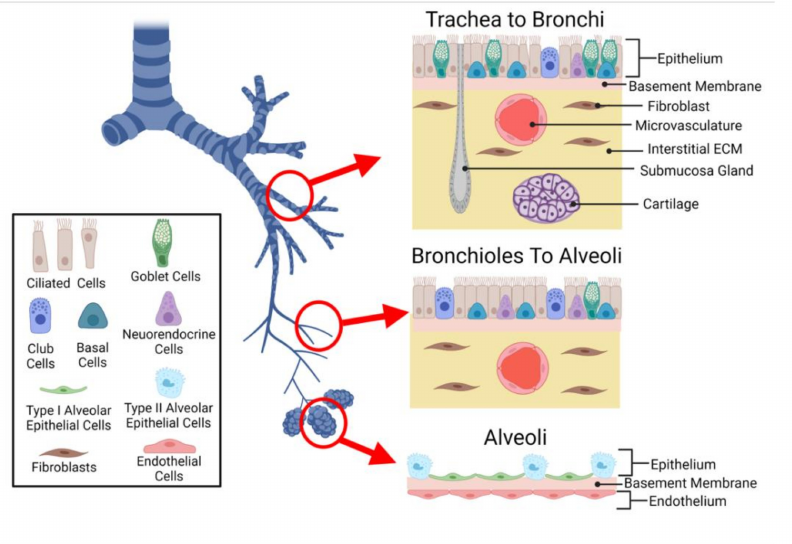
Figure 1. Cells of the Lung. The conducting airways are lined with a pseudostratified epithelium, including mucus producing goblet cells, ciliated cells, neuroendocrine cells, and basal cells. The alveolar epithelium is composed of type 1 flattened epithelial cells and cuboidal type 2 epithelial cells. The submucosa layer of the airways contains interstitial and vascular cells, while the alveolar– capillary interface sees the epithelium in close proximity to the